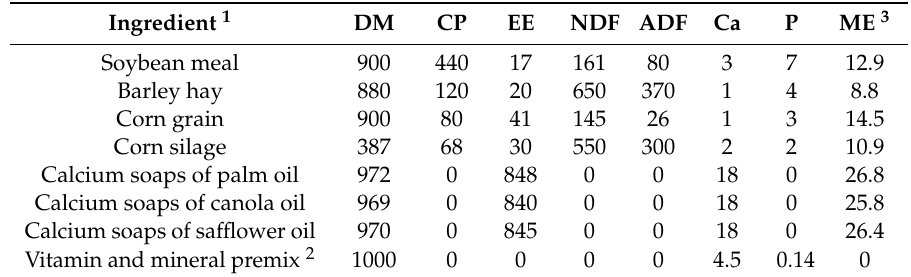
Table 1. Chemical composition (g / kg dry matter (DM)) of individual feedstu ff s and lipid supplements used in the experimental